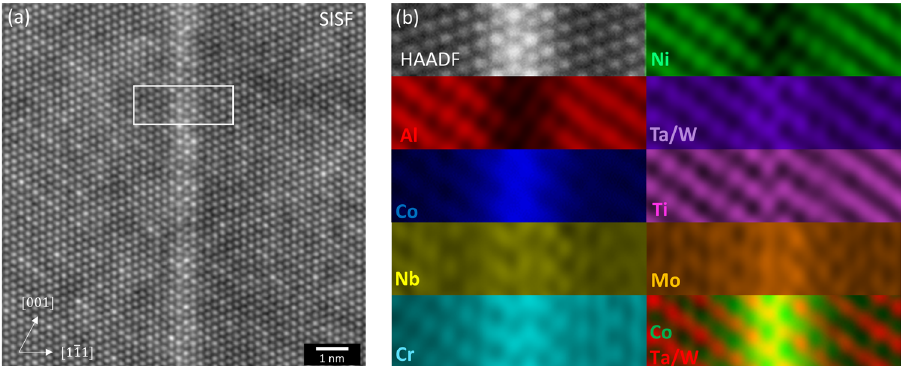
Fig. 5 Atomic resolution characterization of a SISF in TSNA-1. a HAADF STEM image of a SISF in TSNA-1 and ( b ) atomic resolution chemical maps of the SISF. The lowest right map is a composite of the Co and Ta/W maps revealing the Co 3 (W,Ta) χ phase. Different colors were used to distinguish the different